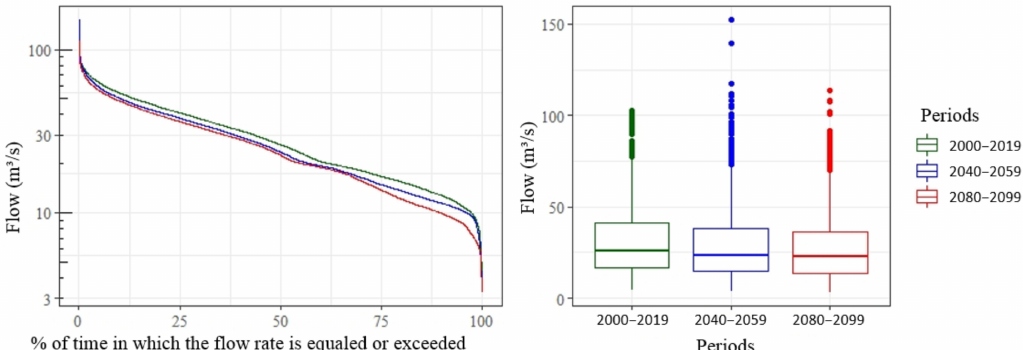
Figure 6. Comparison of the flow range of the base period 2000–2019 and the analysis periods 2040–2059 and 2080–2099.